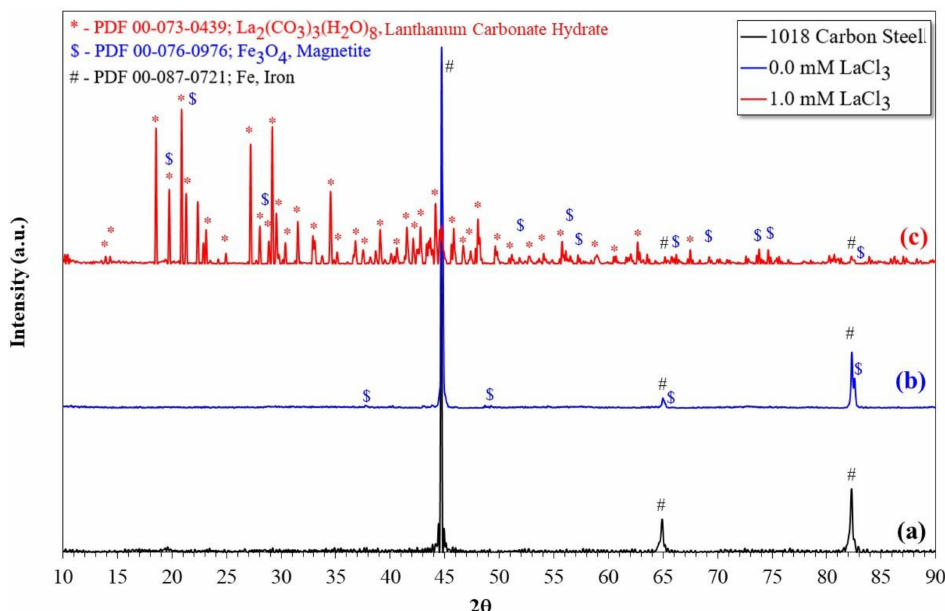
Figure 9. X-ray diffraction pattern of the surface of 1018 carbon steel; ( a ) not corroded, ( b ) corroded, ( c ) corroded with the addition of LaCl 3